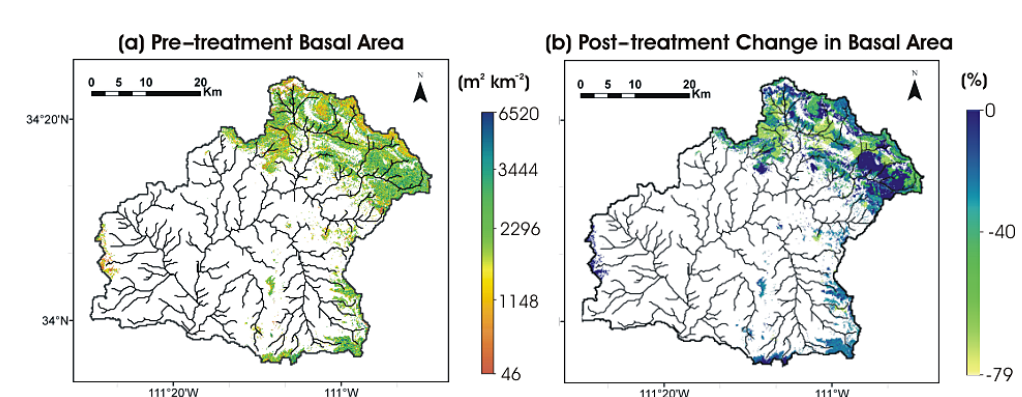
Figure 3. Spatial distribution of ponderosa pine consensus restoration for (a) pre-treatment basal area conditions, and (b) change in basal area due to forest treatment. Data provided by the Laboratory of Landscape Ecology and Conservation Biology of the Northern Arizona University